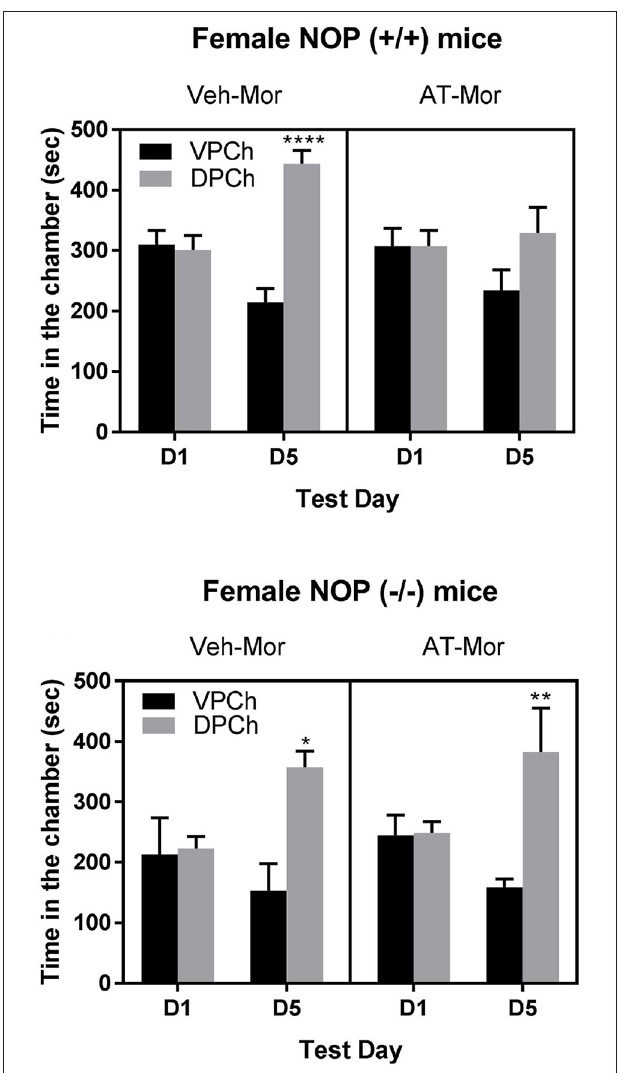
FIGURE 2 | Effects of AT-312 on morphine-induced motor stimulation during the conditioning days in the CPP chambers in mice lacking NOP and their wild-type littermates/controls. On each conditioning day, wild-type (Upper) and NOP knockout (Lower) mice were treated with vehicle or AT-312 (3 mg/kg; i.p.; n = 6 mice per treatment for each genotype) 5min before morphine (7.5 mg/kg, s.c.) and distance traveled by mice in the morphine-paired chamber (DPCh) was recorded for 60min each day. Distance traveled by the mice in the saline-paired chamber (VPCh) was also recorded, in which mice were injected with vehicle and 5min later with saline. * P < 0.05, ** P < 0.01 and **** P < 0.0001, a significant increase in distance traveled by mice in the DPCh vs. their respective VPCh on this day.